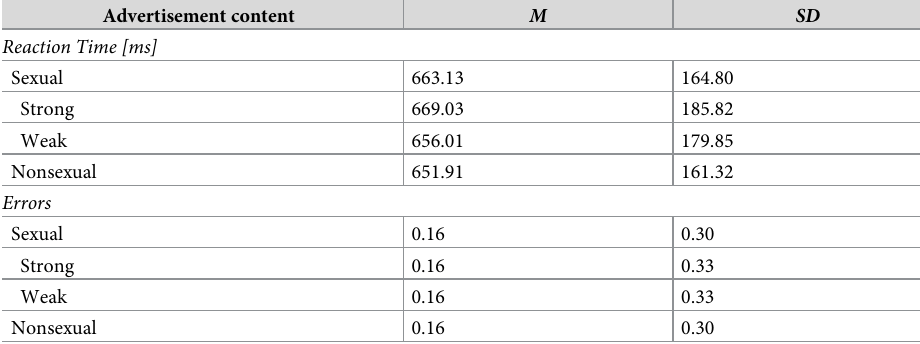
Table 3. Reaction time and number of errors in the context of sexual (strong and weak) and nonsexual